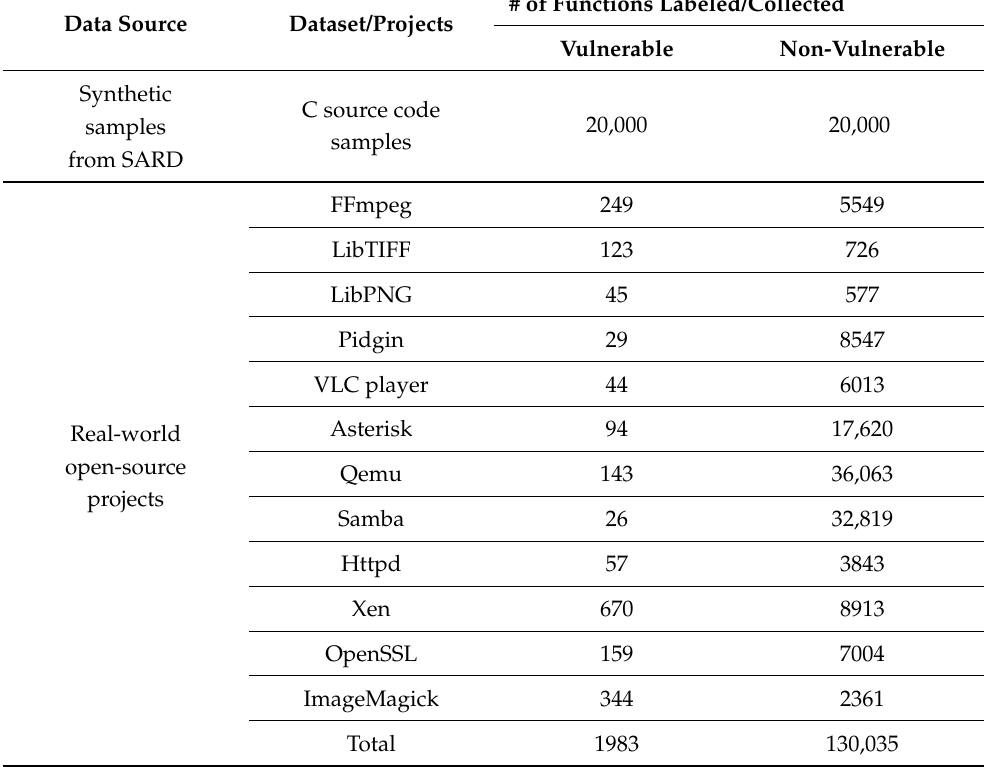
Table 2. The data sources used for